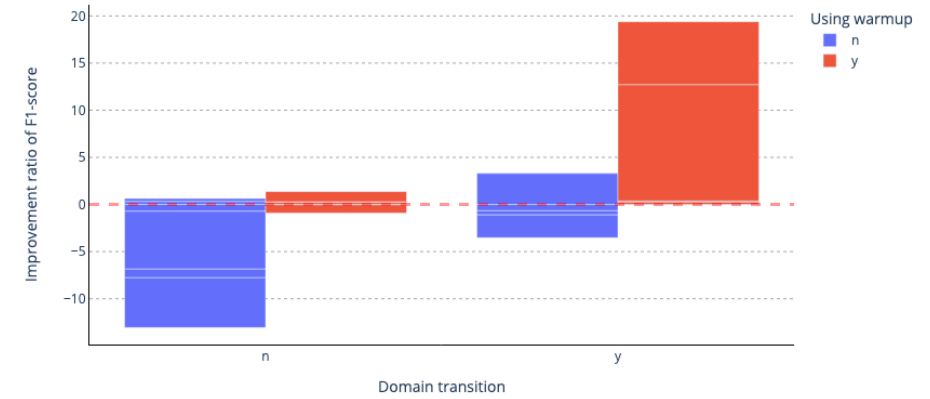
Figure 5. F1-score’s increase and decrease rate according to the presence or absence of prior learning and downstream domain differences. On the x-axis, n is a domain, and the same applies for the y-axis. Blue bars: experiments that do not use warm-up; red bars: experiments using warm-up. Pink dotted line: baseline